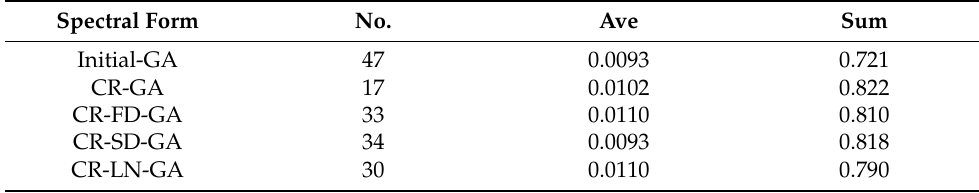
Table 3. Importance of optimal characteristic bands after secondary screening by using